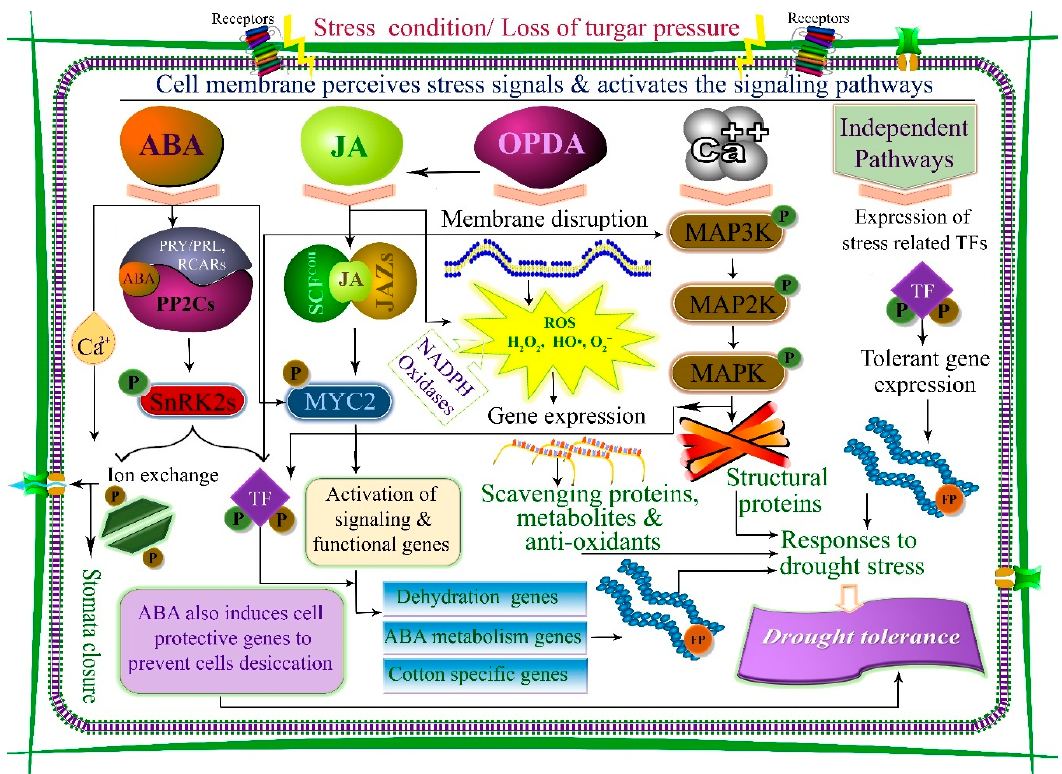
Figure 1. Drought-induced cellular and molecular signaling pathways to enhance drought tolerance in plants. The cell membrane perceives stress signals and triggers signaling. In the presence of abscisic acid (ABA), a complex of PRY/PRL, RCARs, and PP2Cs is formed, which dissociates PP2Cs from SnRK2 and activates NnRK2 protein (P). SnRK2 is auto-activated when separated from PP2C. Activated SnRK2 triggers and regulates molecular and physiological responses. Similarly, jasmonic acid (JA) is engaged with the jasmonate-zim domain (JAZ) in a complex with SCF and TFs (MYC2), and activates stress- responsive genes. Overproduction of reactive oxygen species (ROS) in response to oxo-phytodienoic acid (OPDA) and JA activates scavenging genes and act like a stress-signaling unit. Calcium (Ca 2+ ) interacts with mitogen-activated protein kinase (MAPK) cascade proteins to activate transcriptional factors and signaling genes. Finally, functional proteins (FP) are synthesized for drought-stress responses.